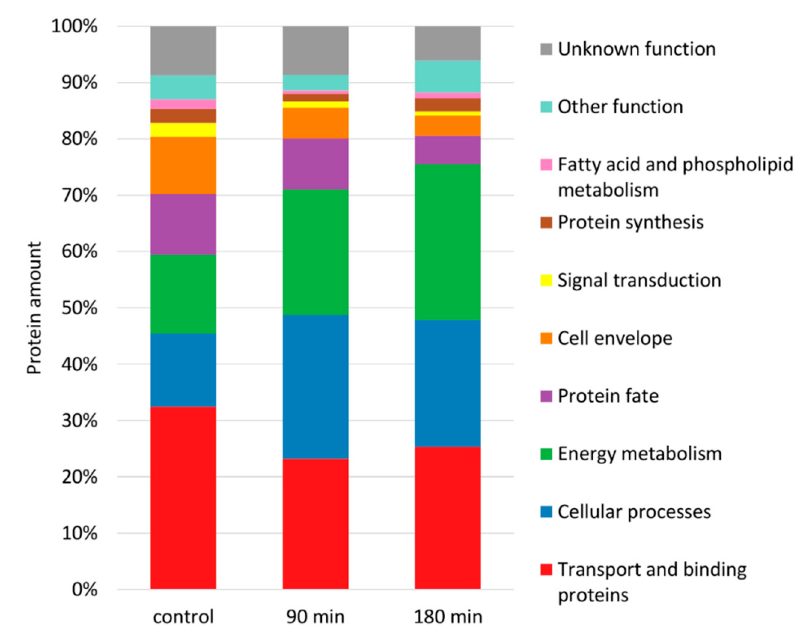
Figure 3. Changes in the composition of the membrane proteome after nisin treatment. The fraction of absolute protein amounts assigned to functional categories (TIGRFams, first level) was calculated by summing up iBAQ [51] intensities for all proteins quantified in the membrane fraction at the respective sampling point, which are predicted to be localized in the cell membrane, the cell wall or have an unknown localization. Only the highest abundant functional groups are shown. All other functional categories are summarized as “other function”.